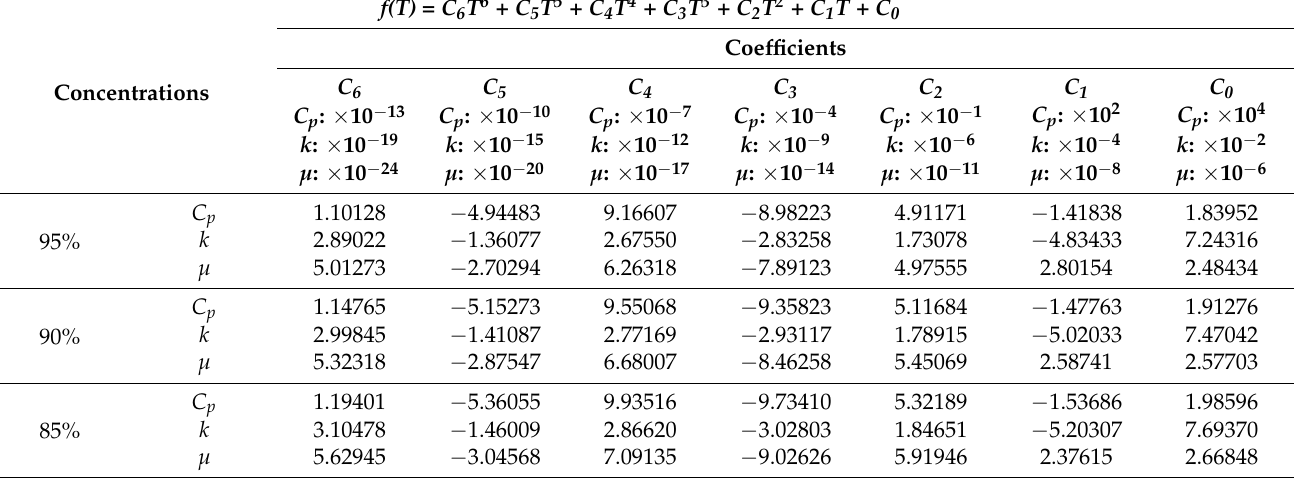
Figure 3. Microthruster computational domain. ( a ) Hexahedral element fluid domain. ( b ) Tetrahedral element solid domain. Table 2. Polynomial coefficients of the specific heat capacity, thermal conductivity, and dynamic viscosity of 85, 90, and 95 wt% hydrogen peroxide decomposed gas